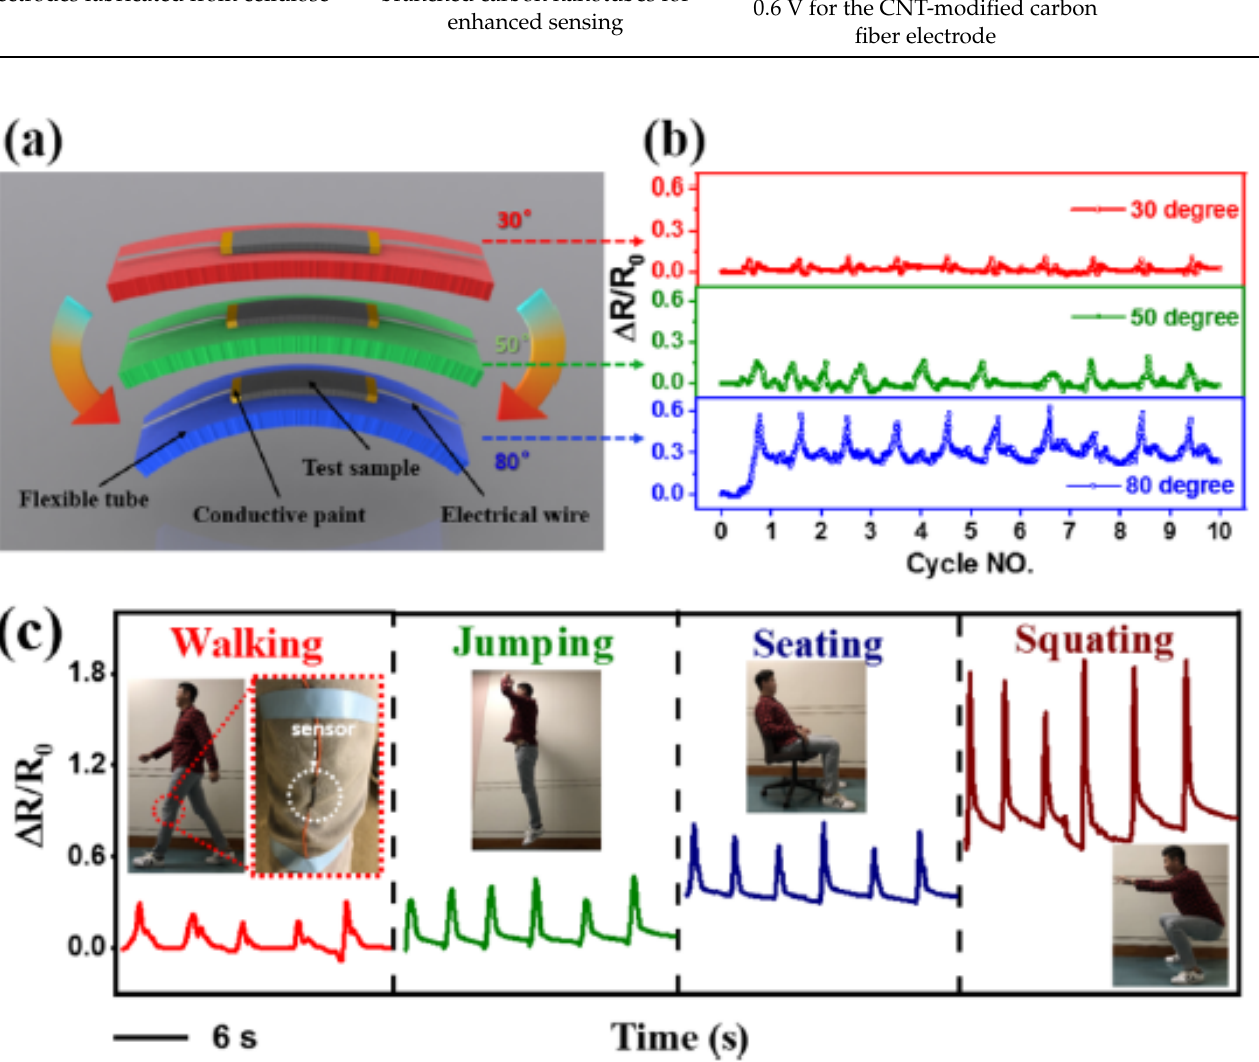
Figure 8. ( a ) Schematic of the 0.7 TPU/CNS test sample under bending with different bending degrees; ( b ) corresponding electrical signal of Δ R/R 0 plotted as a function of cycle number under 30°, 50°, and 80° bending. ( c ) Response of a sensor to different human motion patterns (e.g., walking, jumping, seating, and squatting) when the sensor was mounted on the knee joint. Reprinted with permission from [108], Copyright© 2018, American Chemical Society.